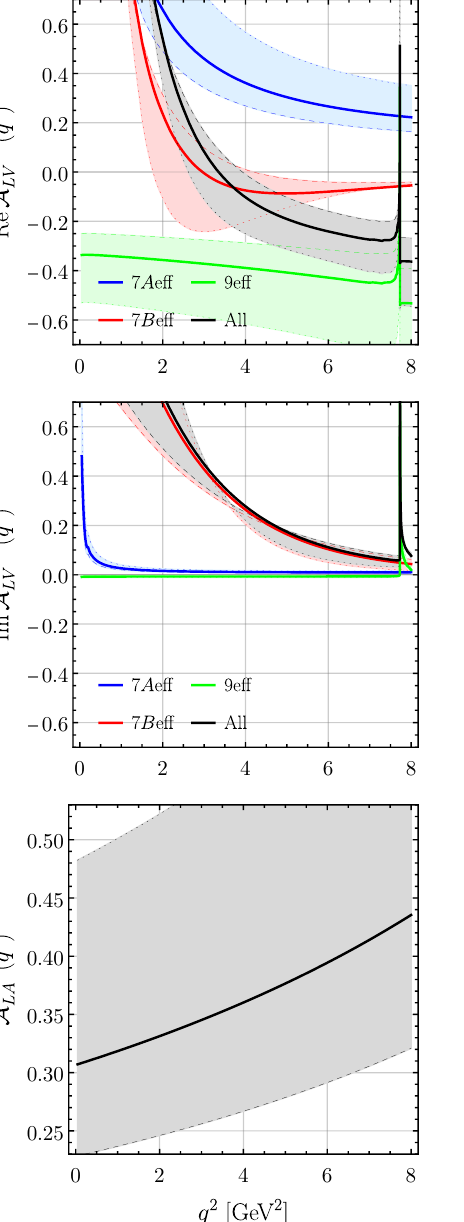
= (0 . 40 ± 0 . 15) GeV and s